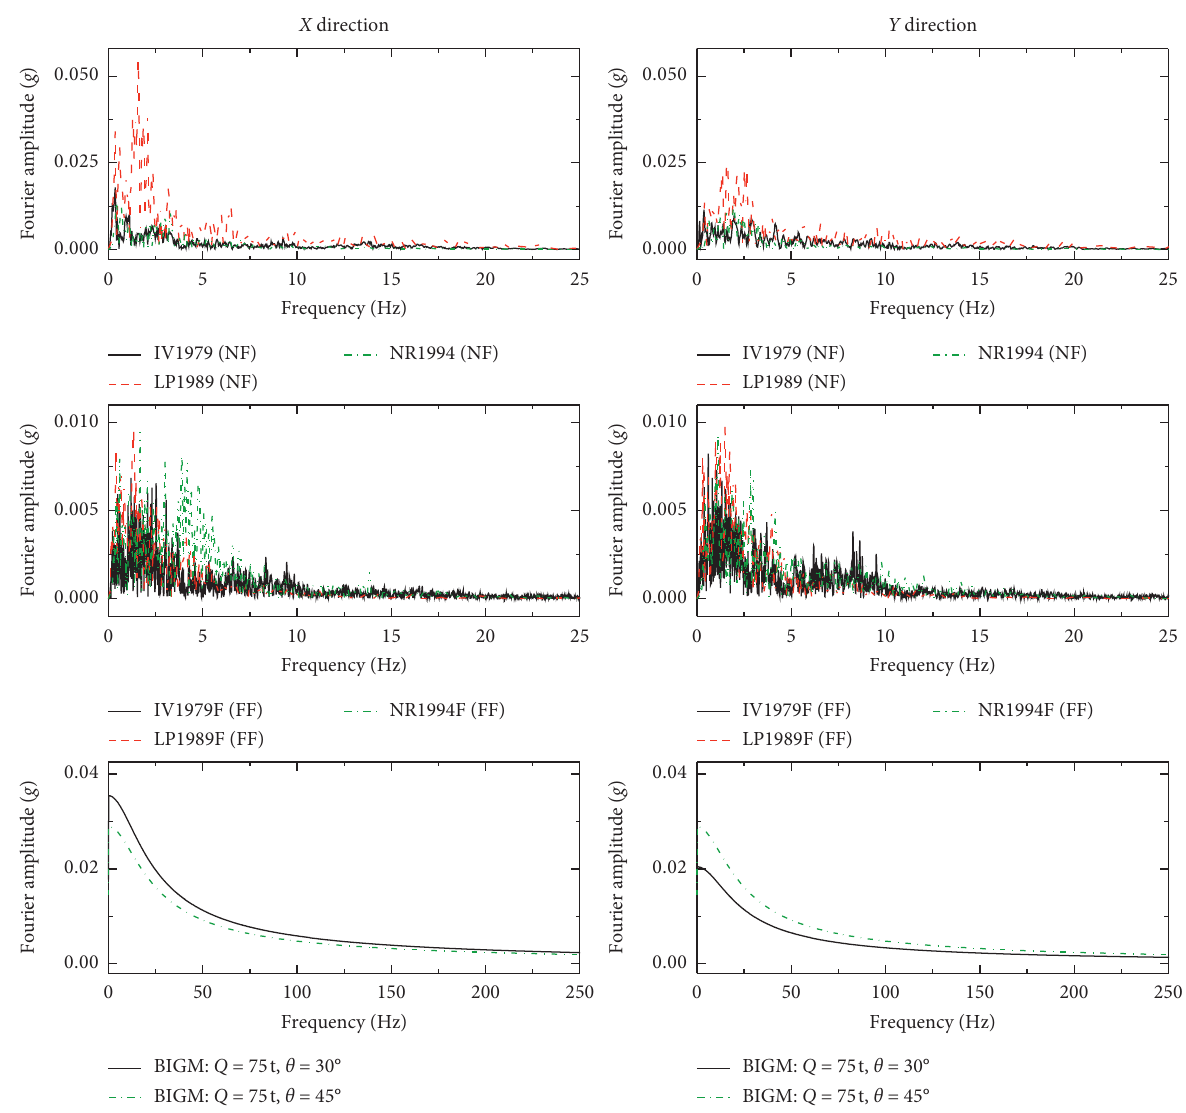
Figure 3: Fourier spectra of NF earthquakes, FF earthquakes, and BIGMs used in the